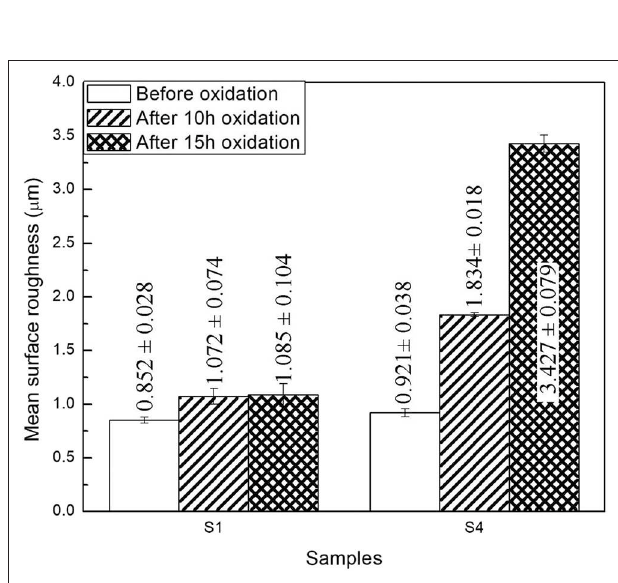
a dense and continuous layer was produced after oxidation at 1,000 ◦ C for 10 h, and a large amount of gray scales were densely distributed on the surface. Composition of the surface was determined by EDS as shown in the top-right corner of Figure 10 , displaying 60.5 O − 39.5 Al (at. %) on the surface. The